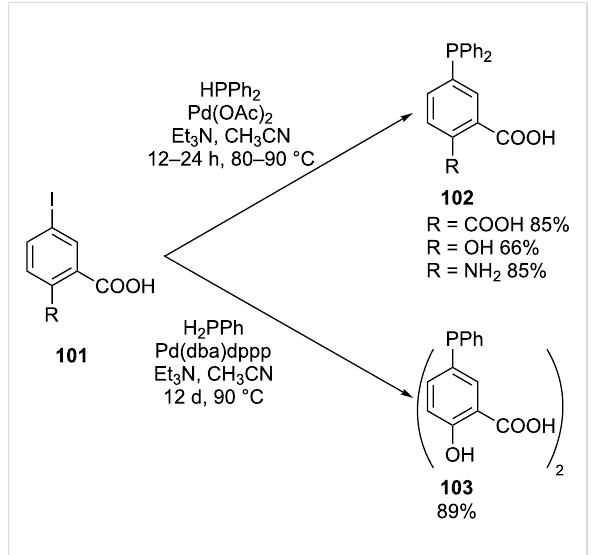
Scheme 29: Palladium-catalyzed P–C cross-coupling reactions between primary or secondary phosphines and functional aryliodides 101 (dba = dibenzylideneacetone, dppp = 1,3-